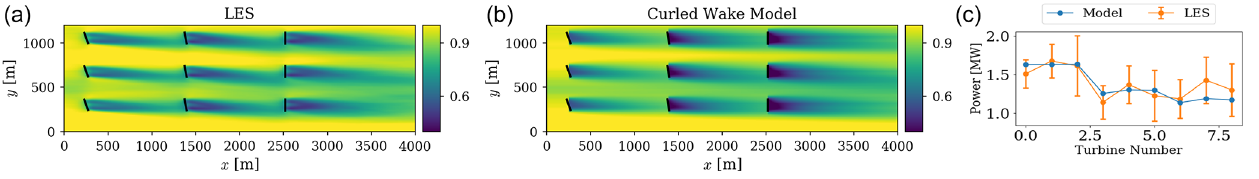
Figure 8. Same as Fig. 8 but for a four-by-three